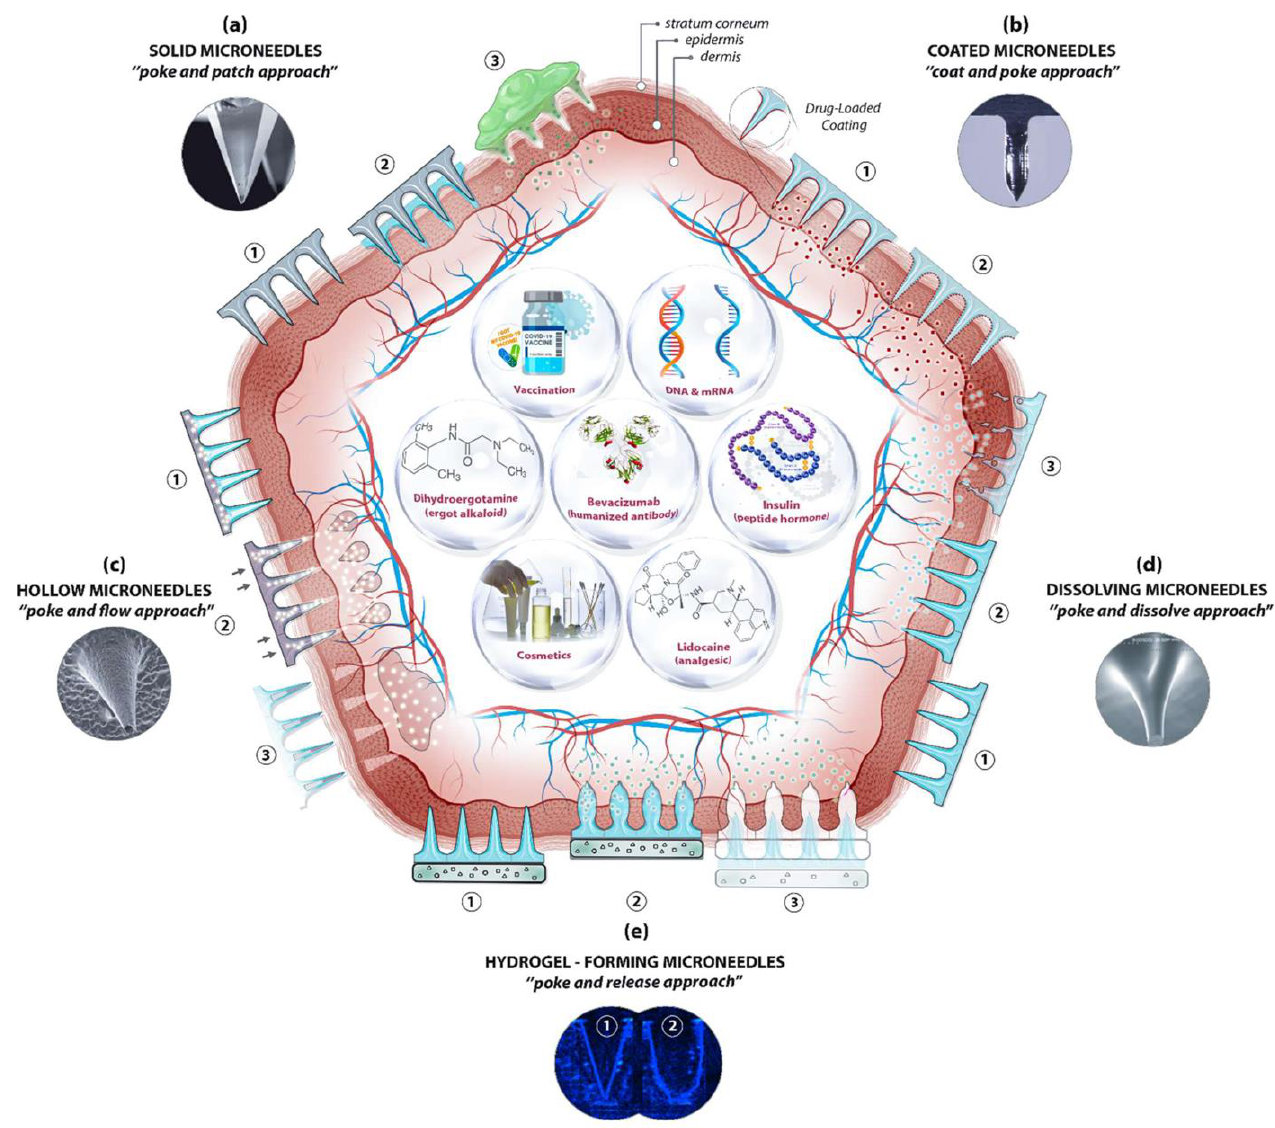
Figure 1. A schematic diagram of microneedle-based drug delivery approaches with a cross-section of the upper layer of the skin. The approaches are ( a ) solid microneedles, ( b ) coated microneedles, ( c ) hollow microneedles, ( d ) dissolving microneedles, and ( e ) hydrogel-forming microneedles. The step-by-step process of each delivery approach is numbered from 1 to 3 [46].